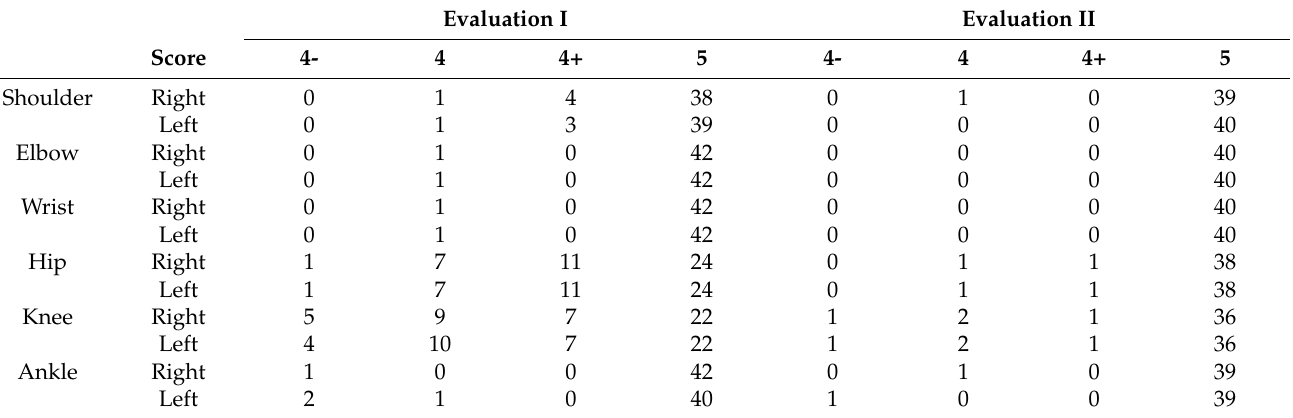
Table A1. Scores on the MRC scale in 43 patients at the first evaluation and 40 patients at the second evaluation.